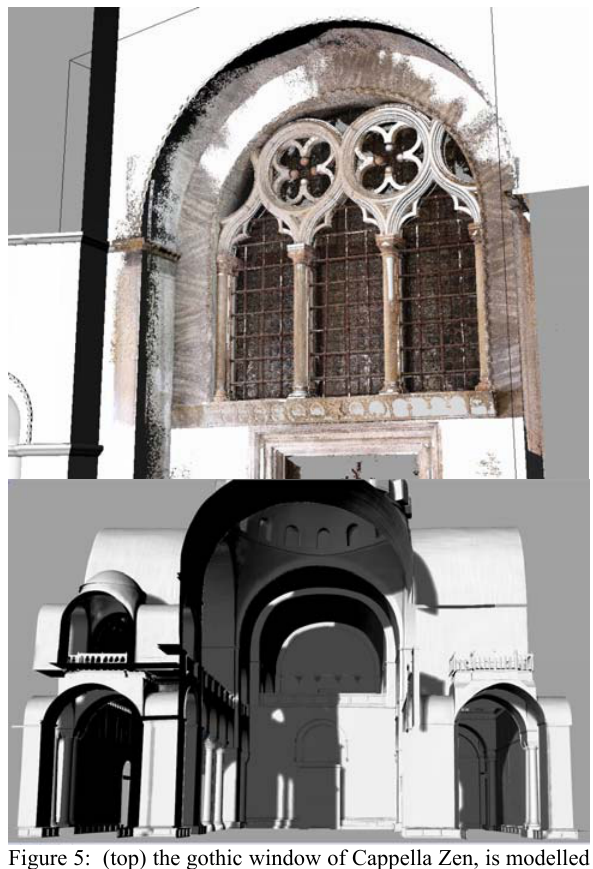
Figure 5: (top) the gothic window of Cappella Zen, is modelled by using sections extracted from the corresponding point cloud. In the image point cloud and NURBS model are overlapped. (bottom) general view of the